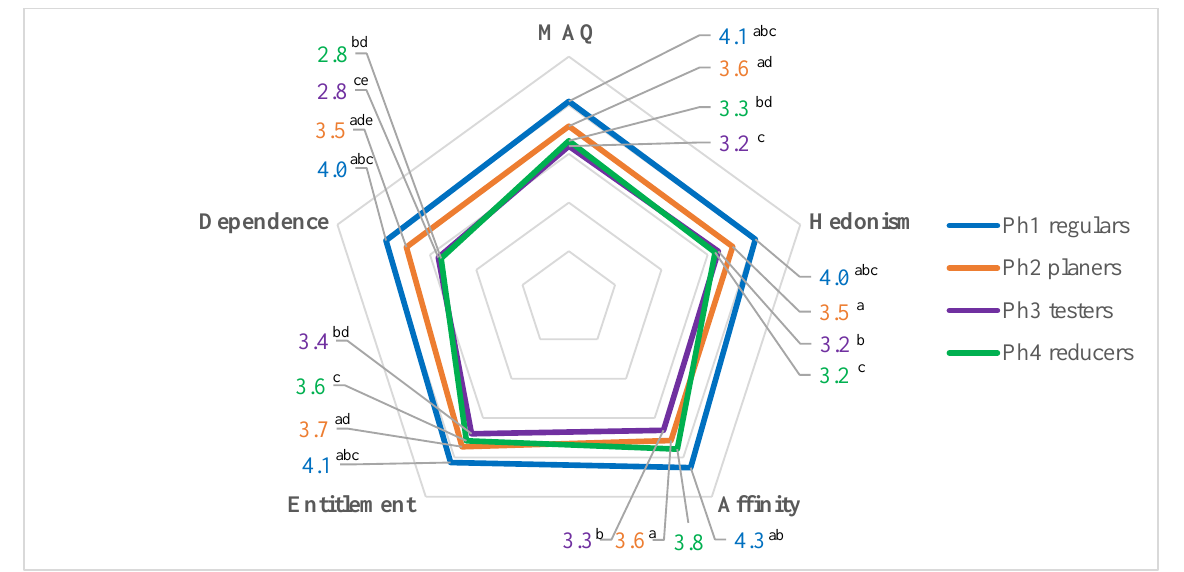
Figure 3. Phases and Meat Attachment Questionnaire (MAQ) results (5-point Likert scale: definitely not (1) — definitely yes (5) for total MAQ and individual categories; The values with the same superscript letters in a total and individual MAQ categories are significantly different in Tukey ’ s post-hoc test results ( p < 0.001).